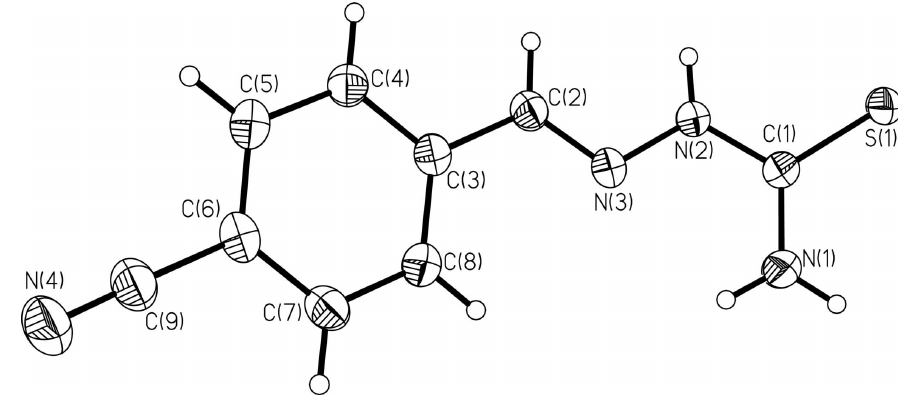
Figure 1 The molecular structure of the title compound, showing the atomic numbering scheme. Displacement ellipsoids are drawn at the 30% probability